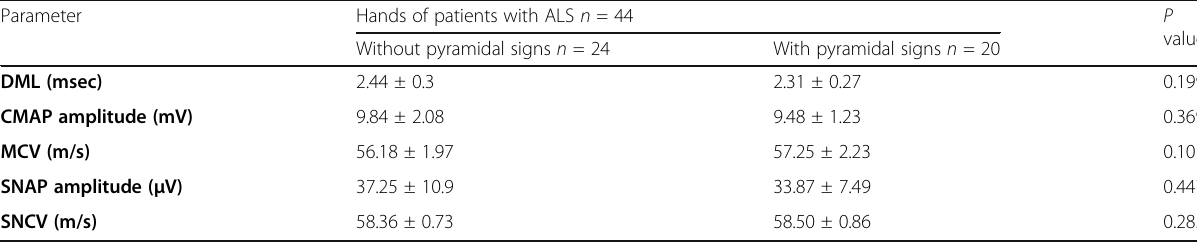
Table 4 Ulnar nerve conduction parameters of patients with amyotrophic sclerosis Parameter